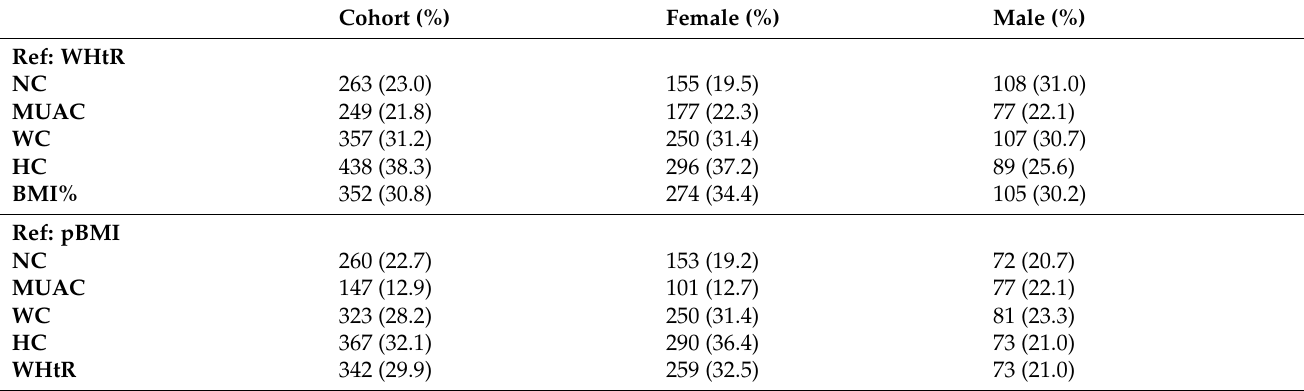
Table 7. Predicted prevalence of obesity based on the new cut-off values using WHtR and pBMI. Cohort (%) Female (%) Male